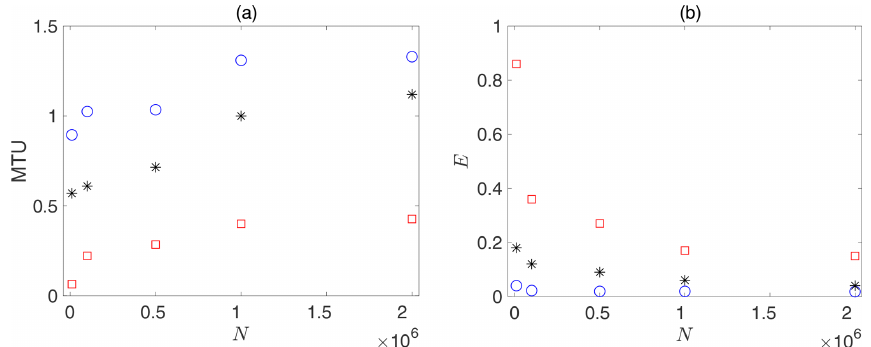
Figure 7. Comparison of the short-term predictions quality for RC–ESN (blue circles), RNN–LSTM (black stars), and ANN (red squares) as the size of the training set N is changed from N = 10 4 to N = 2 × 10 6 . Panel (a) shows the prediction horizon (when e(t) reaches 0 . 3), and panel (b) shows the average error E (see Eq. 9). The hyperparameters in each method are optimized for each N